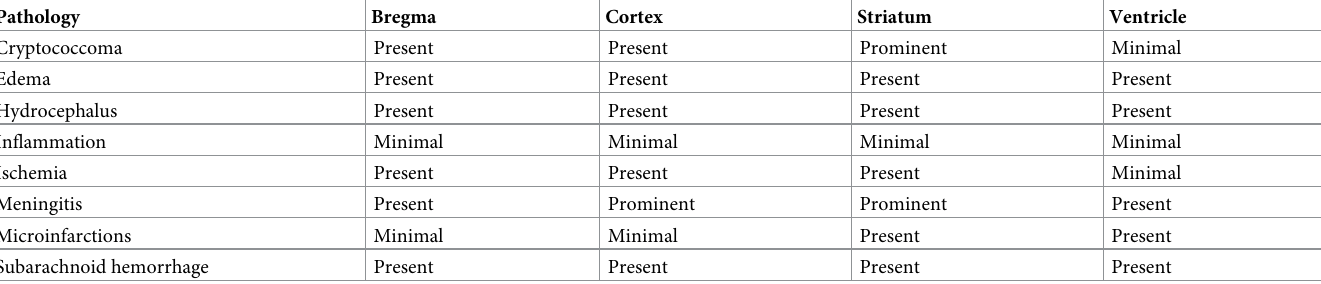
Table 3. Pathological similarities observed in mice and humans with cerebral cryptococcosis.